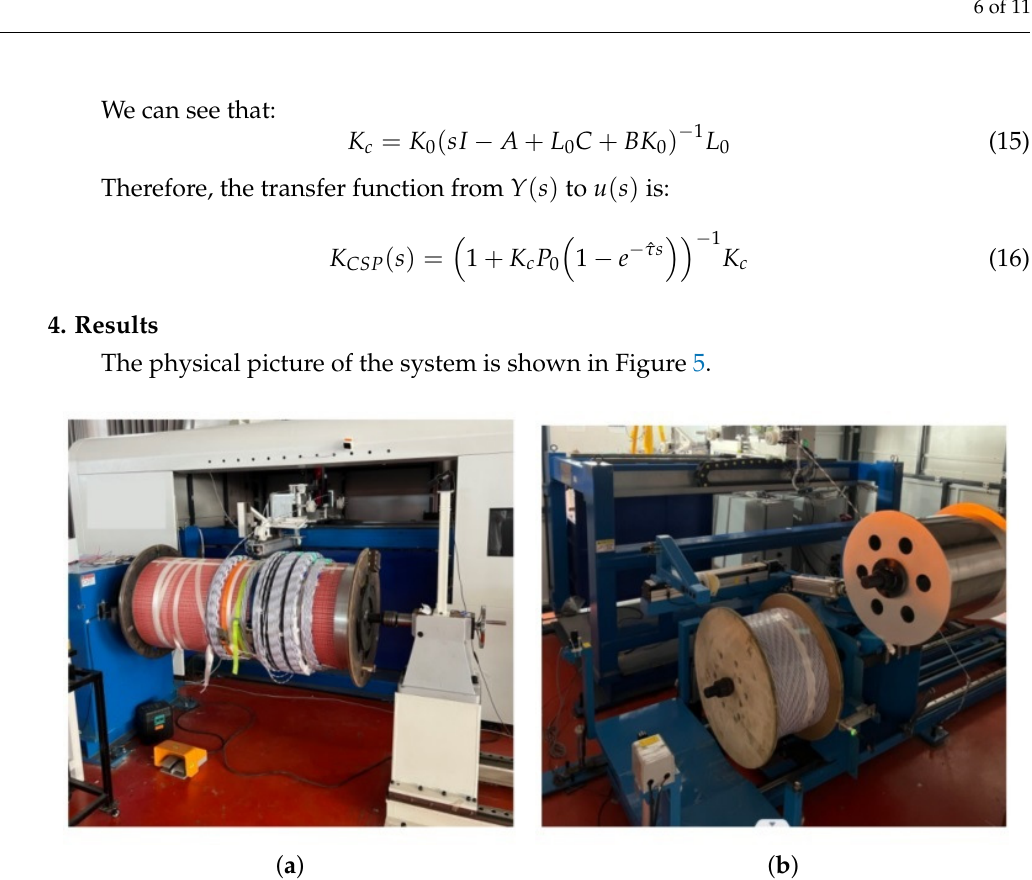
Figure 5. The physical picture of the winding machine; ( a ) front photo of the winding machine, ( b ) back photo of the winding